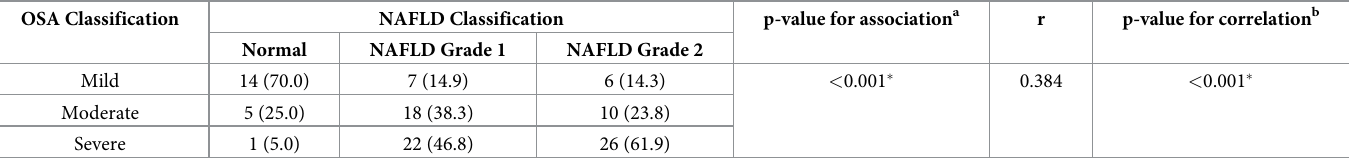
Table 4. The correlation between severity of NAFLD and OSA